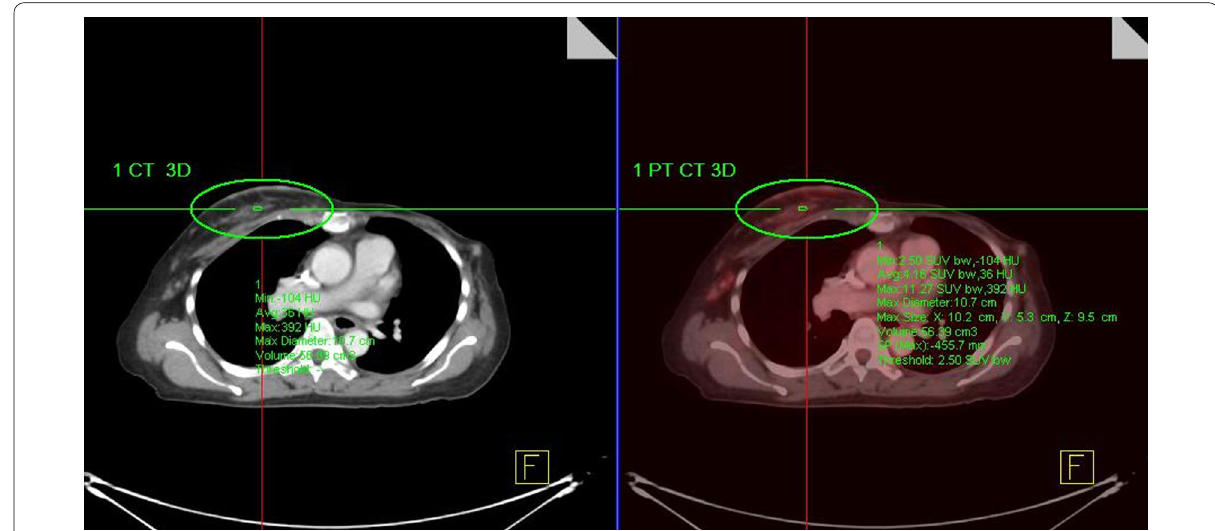
Fig. 4 Forty-five-year-old female, history of left mastectomy with suspicious right nodule noted on ultrasound. A small subcentimeter density lesion (left) is seen without FDG-avidity on the correlated fused 18 F FDG PET-CT (right). Biopsy was negative for malignancy